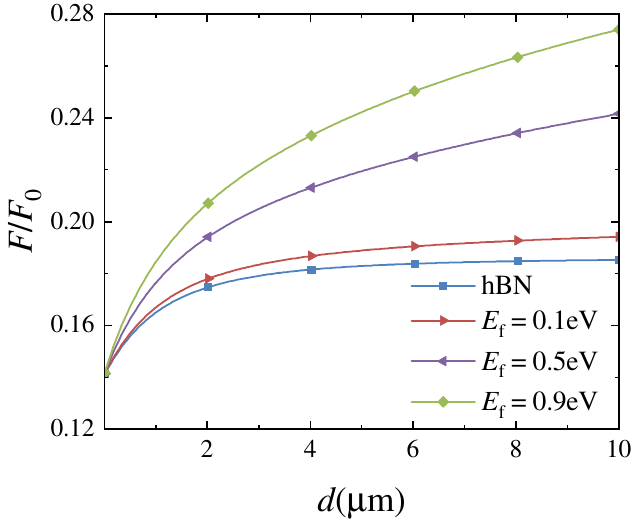
Figure 3. The relationship between the relative Casimir force and the separating distance d . The blue line represents the force between two identical hBN bulks, while the other lines represent the force between two graphene-covered hBN bulks at different Fermi